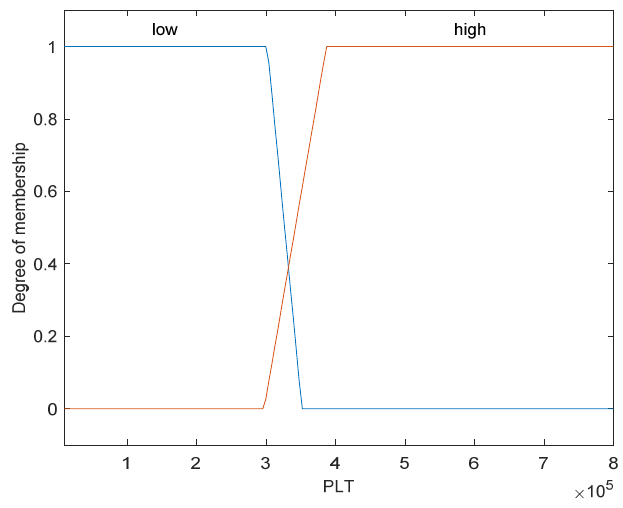
Figure 4. Membership function of CRP as input variable.